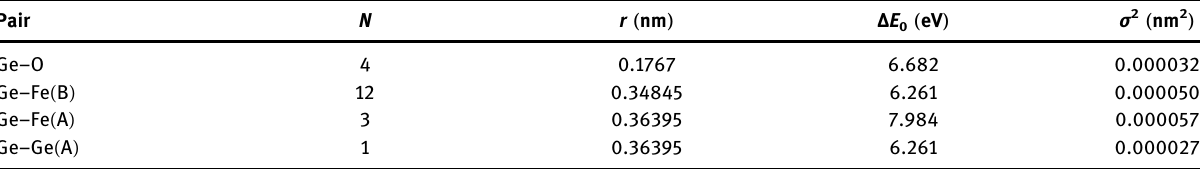
Table A1: Resultant values of the interatomic distance from structure analysis of Ge K - EXAFS for the crystalline Fe 2.7 Ge 0.3 O 4 sample Pair